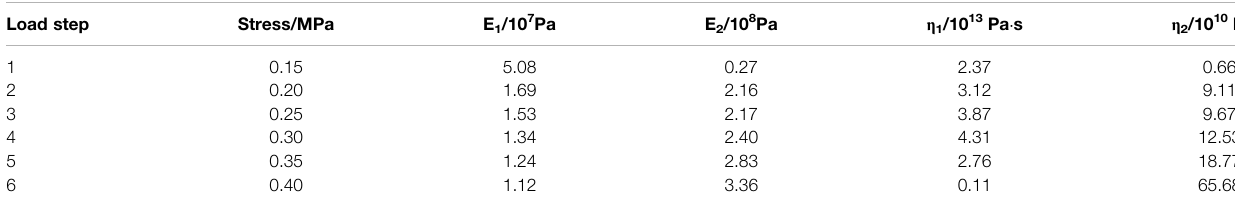
TABLE 5 | Creep parameters of saturated Q 2 loess sample No. 3